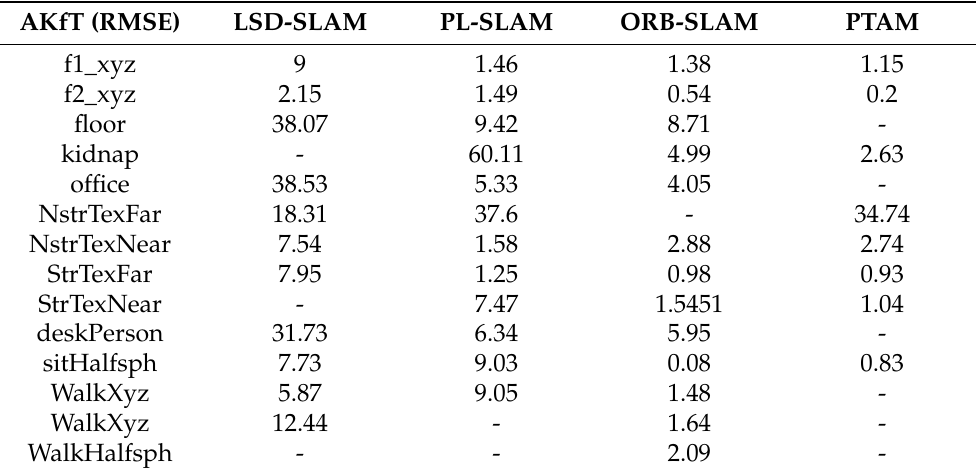
Table 3. Absolute trajectory error on the TUM RGB-D